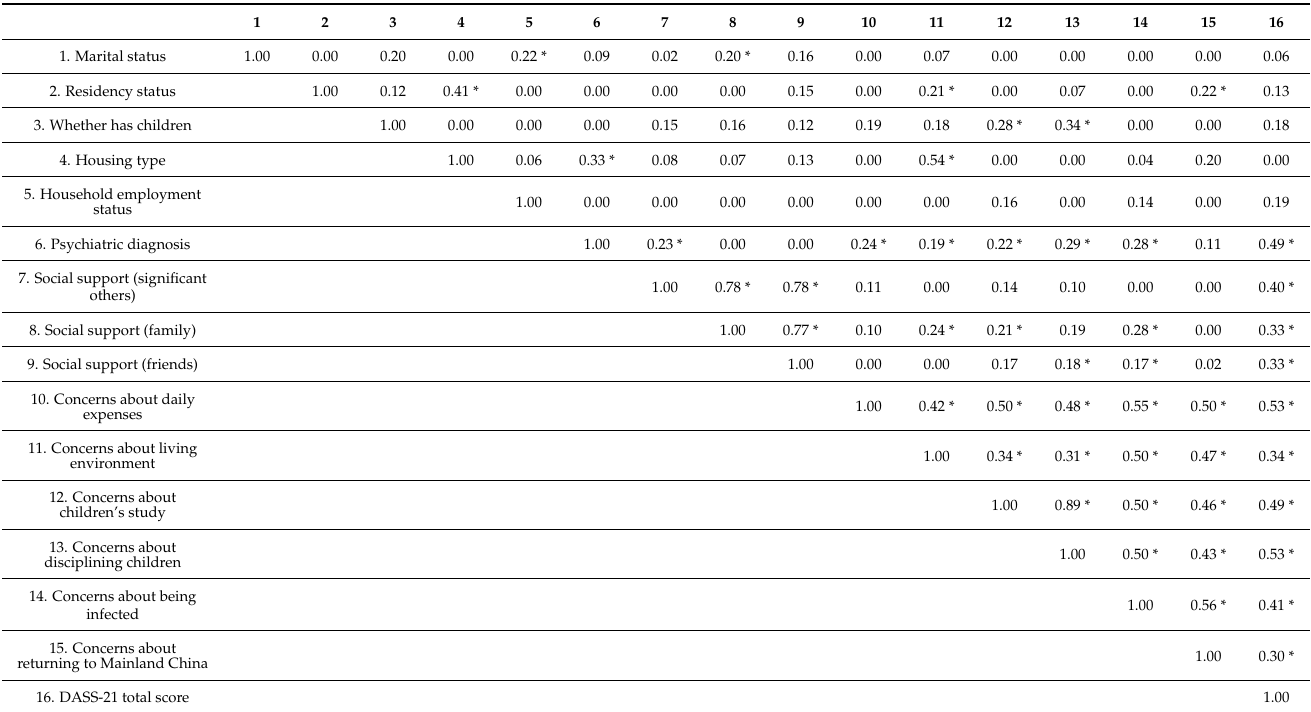
Table 4. Correlation Between